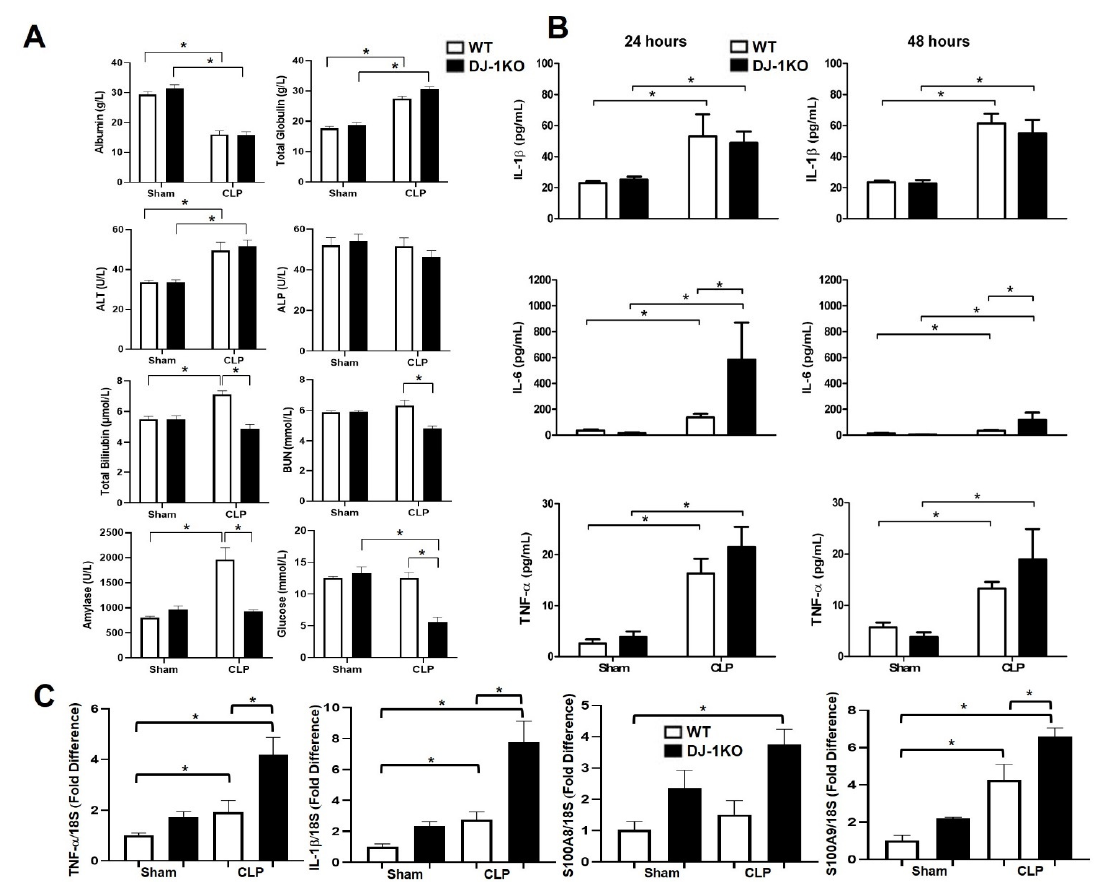
Figure 3. DJ-1 deficiency exacerbates inflammation post-CLP. ( A ) Bars are mean + SEM of VetScan- derived chemistry profiles of albumin, total globulin, alamine aminotransferase (ALT), alkaline phosphatase (ALP), total bilirubin, blood urea nitrogen (BUN), amylase, and glucose in serum of WT and DJ-1KO mice at 48 h post CLP or sham operation. n = 9–11/group. ( B ) Bars are mean + SEM of IL-1 β , IL-6, or TNF- α in serum of WT and DJ-1KO mice at 48 h post CLP or sham operation. n = 9–11/group. ( C ) Bars are mean + SEM of TNF- α , IL-1 β , S100A8, or S100A9 mRNA expression in myocardium of WT and DJ-1KO mice at 48 h post CLP or sham operation. n = 8–11/group. * p < 0.05 .